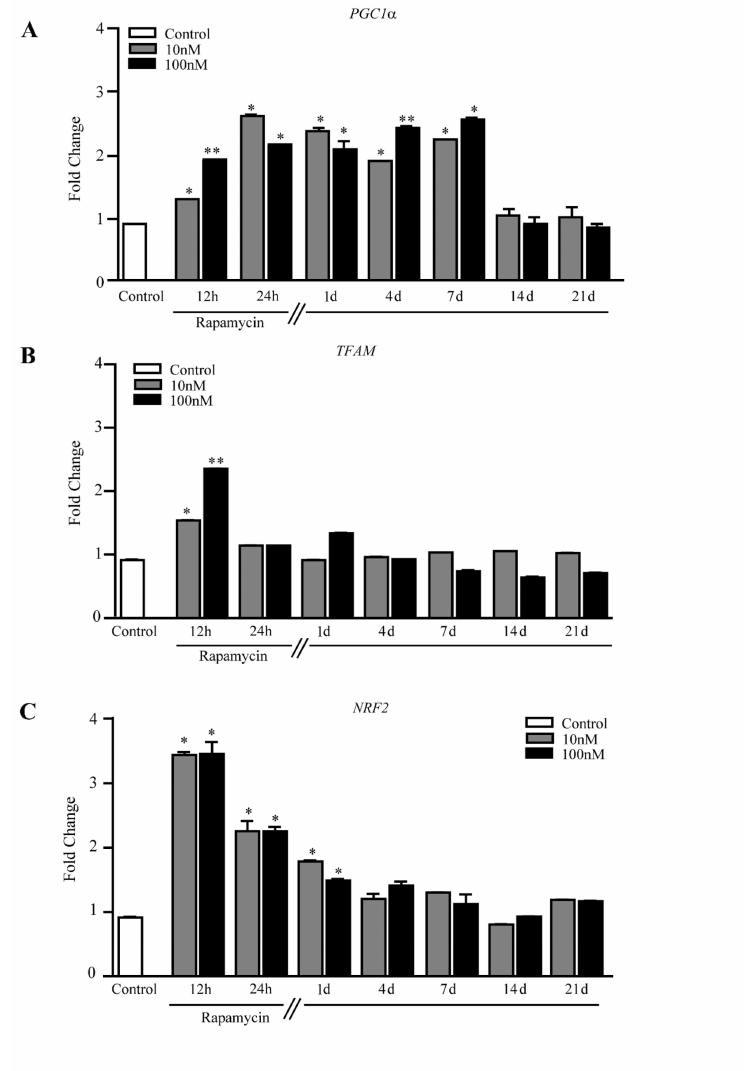
Figure 9. Rapamycin increases mitochondriogenesis-related genes within U87MG cells. RT-PCR for ( A ) PGC1 α , ( B ) TFAM , and ( C ) NRF2 . * p ≤ 0.05 vs. Control; ** p ≤ 0.05 vs. Control and 10 nM